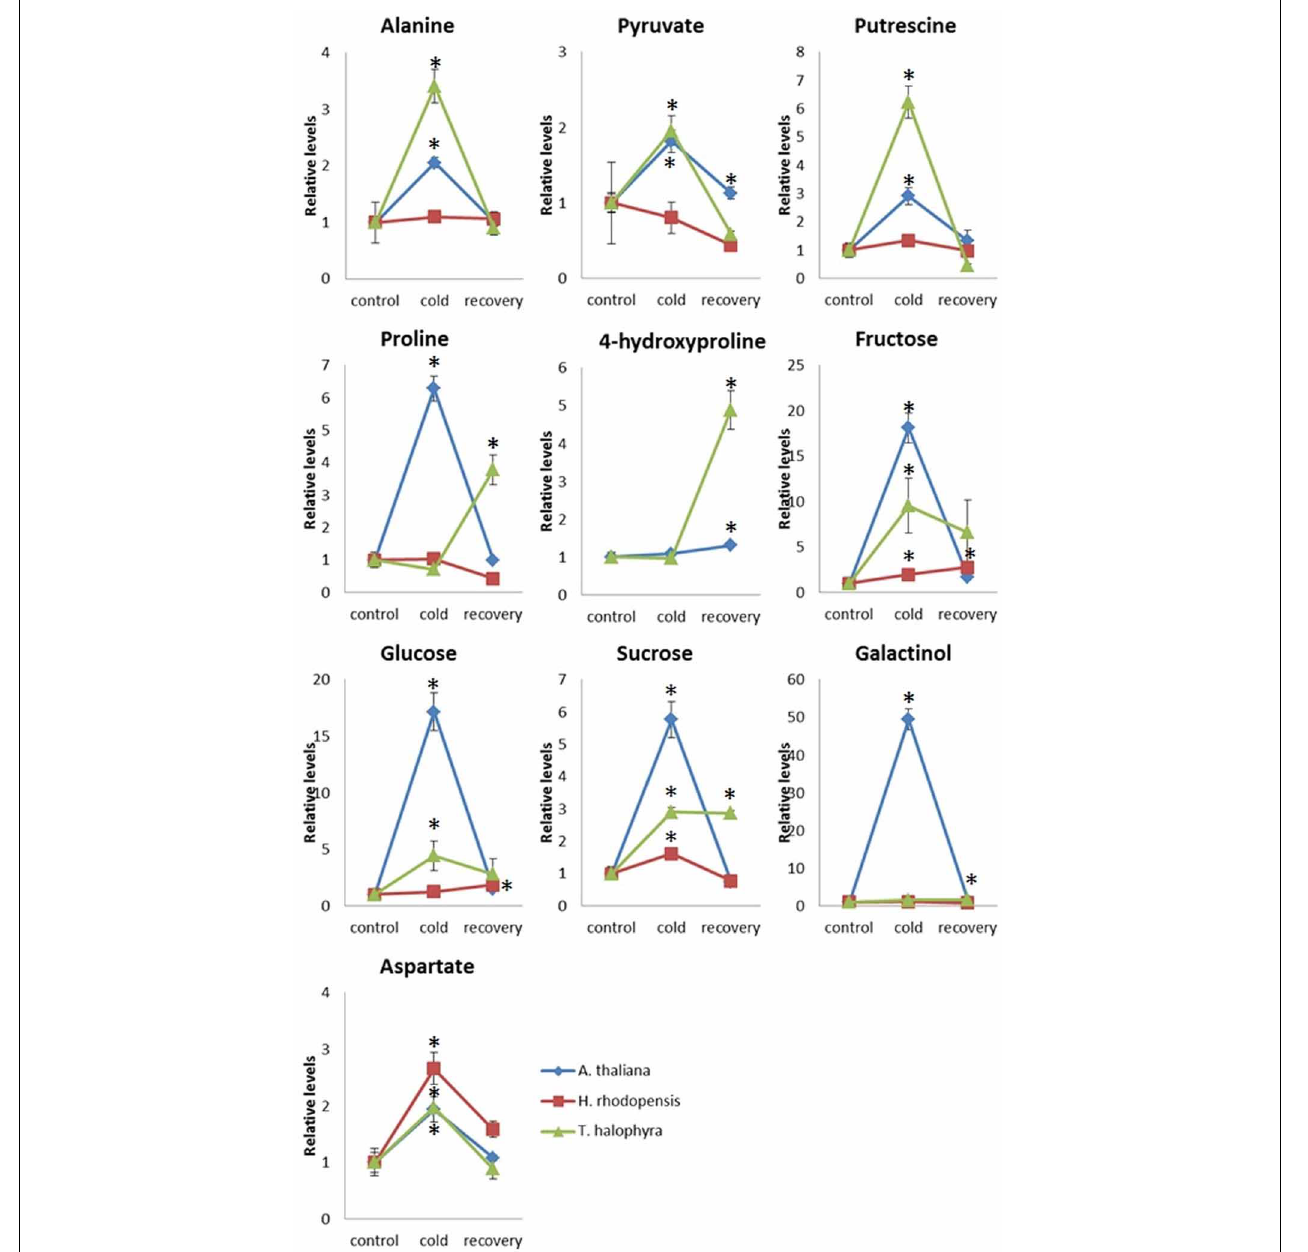
FIGURE 5 | Changes of metabolite levels during cold treatment and subsequent recovery. The levels of metabolites were normalized by those at control conditions in each plant species. Ten metabolites which showed statistically significant changes following the treatment are shown. The